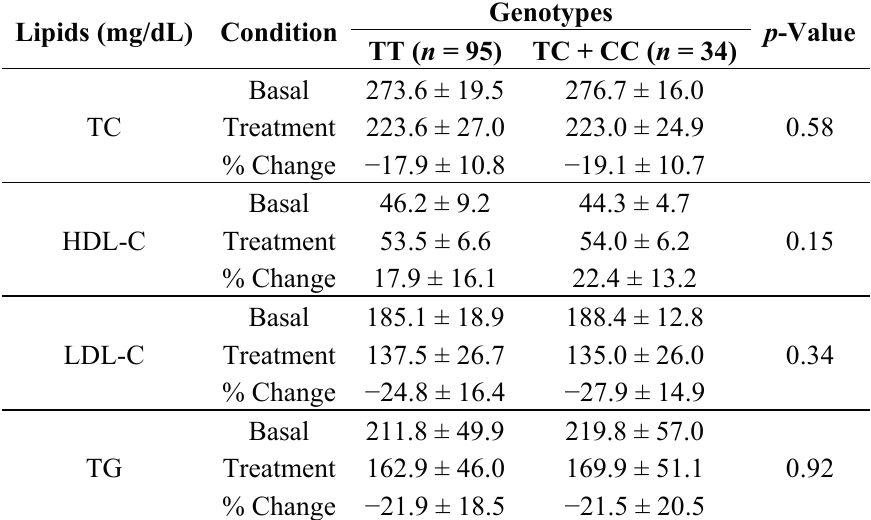
Table 5. Influence of the SLCO1B1 521T>C SNP on atorvastatin treatment (10 mg/day, 4